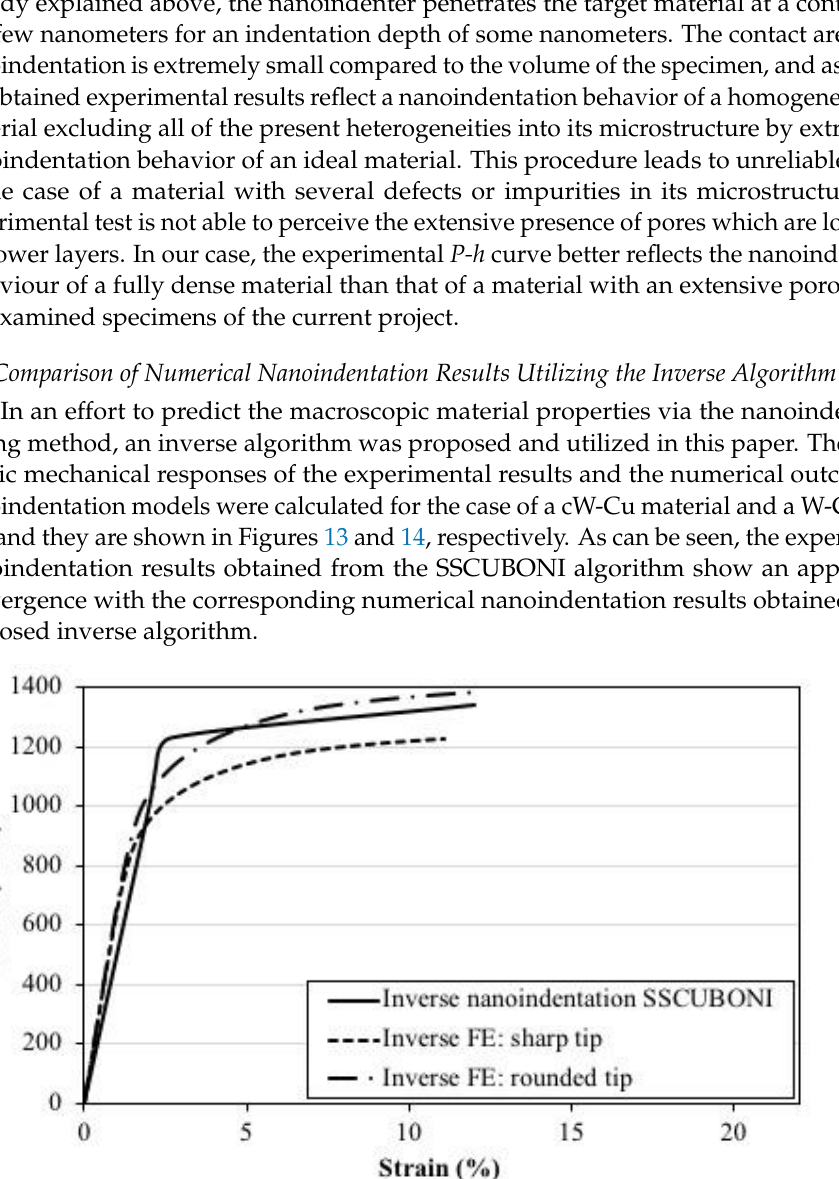
Figure 12. Comparison of the S-S curves of the experimental compression test with the correspond- ing inverse SSCUBONI-based experimental test for the W-Cu specimens.